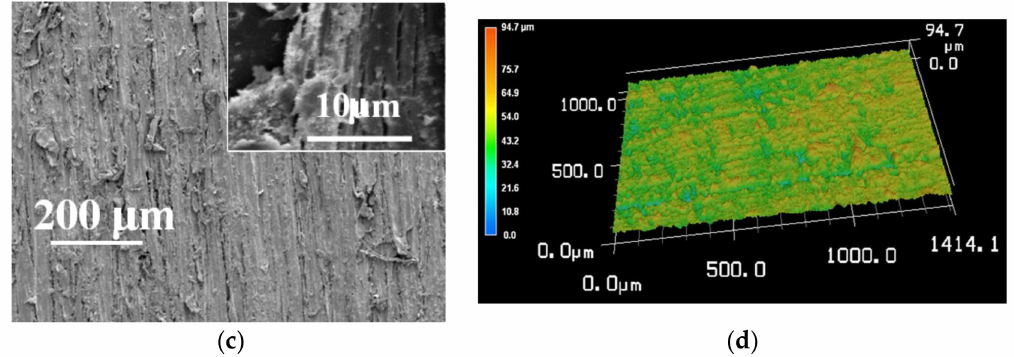
Figure 2. ( a ) Scanning electronic microscopy (SEM) and ( b ) optical laser microscope system (OPM) images of raw wood without sanding (USR) wood. ( c ) SEM and ( d ) OPM images of SR-240 wood. The insets in ( a ) and ( c ) are the magnified SEM images.